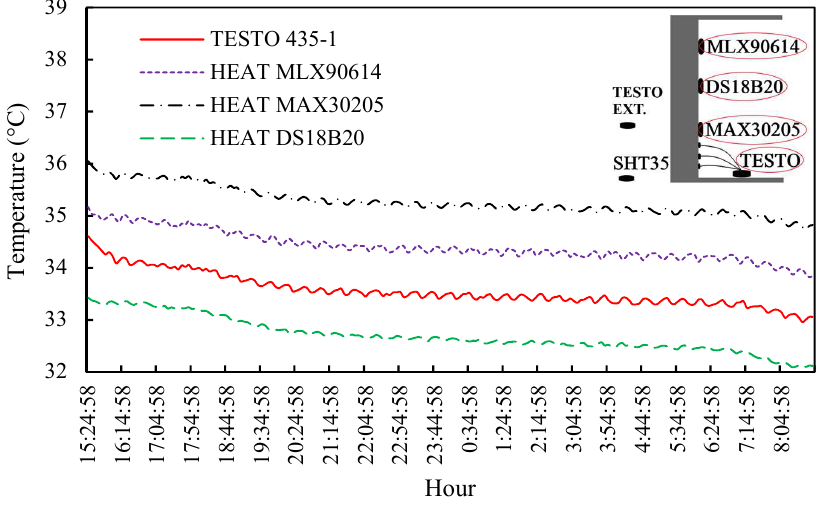
Figure 11. Evolution of the surface temperatures recorded by the three HEATs and the one captured by TESTO 435-1.